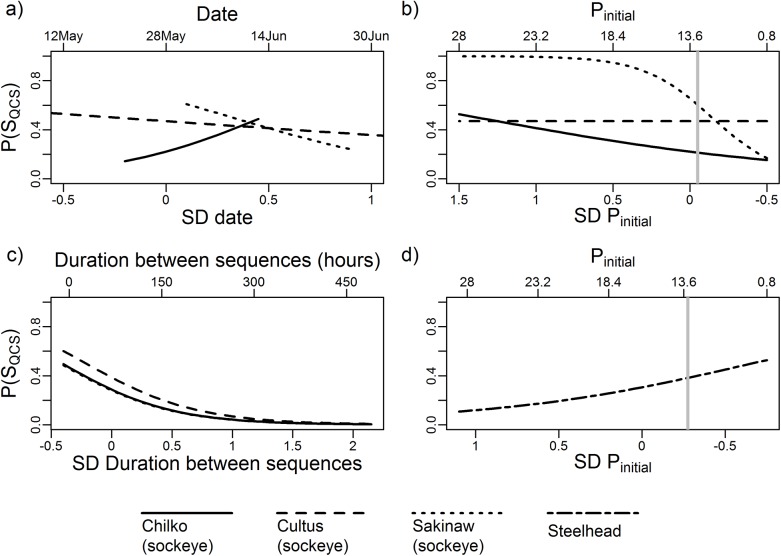
Prediction plots for the probability of survival to the Queen Charlotte Strait acoustic telemetry array [P(SQCS)].Effects of (a) date of arrival at NSOG for sockeye, (b) receiver position of the initial detection sequence on NSOG (Pinitial) for sockeye, (c) duration between the first and second NSOG detections for sockeye, and (d) Pinitial for steelhead. For all effects shown the 95% confidence interval of the model-averaged effect size did not contain zero (Fig 7). The upper x axis depicts the actual values of the variable, and the lower x axis are these values as standard deviations (SD) from the mean. For sockeye date of arrival (a), only the range of dates observed are predicted for each population. Vertical gray bars (panels b and d), indicate the separation of Malaspina Strait (receivers 1–7) from the Strait of Georgia (receivers 8–27). The predictions for survival of Chilko and Sakinaw sockeye across duration values (panel c) are very similar and therefore little separation of the prediction lines occur.